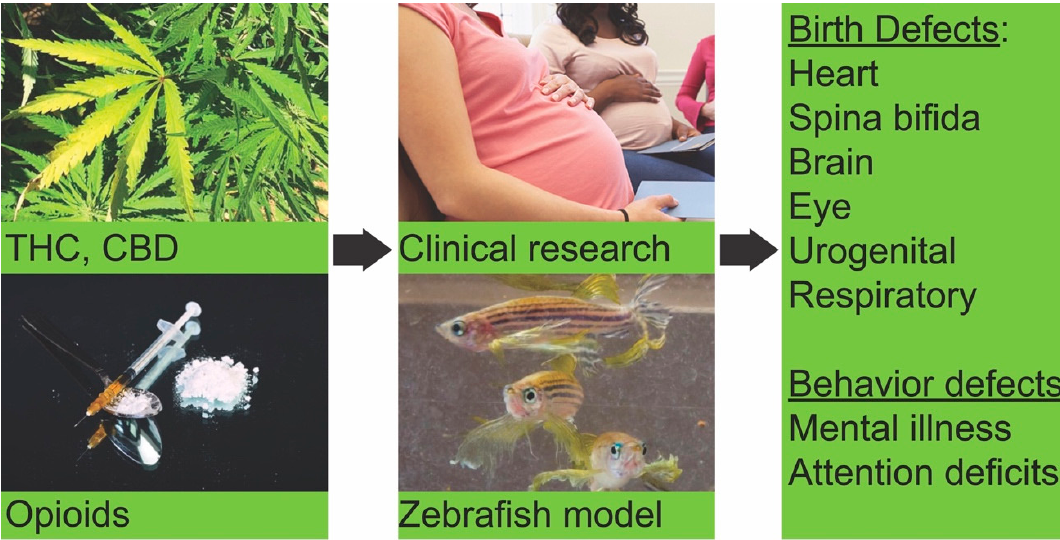
Figure 1. Schematic representations of drug use / abuse during pregnancy and birth outcomes. In utero exposure to ∆ 9-tetrahydrocannabinol (THC), cannabidiol (CBD) or opioids leads to congenital malformations and behavioral changes in babies. Exposure to cannabinoids or opioids during zebrafish development produced similar defects in embryos.